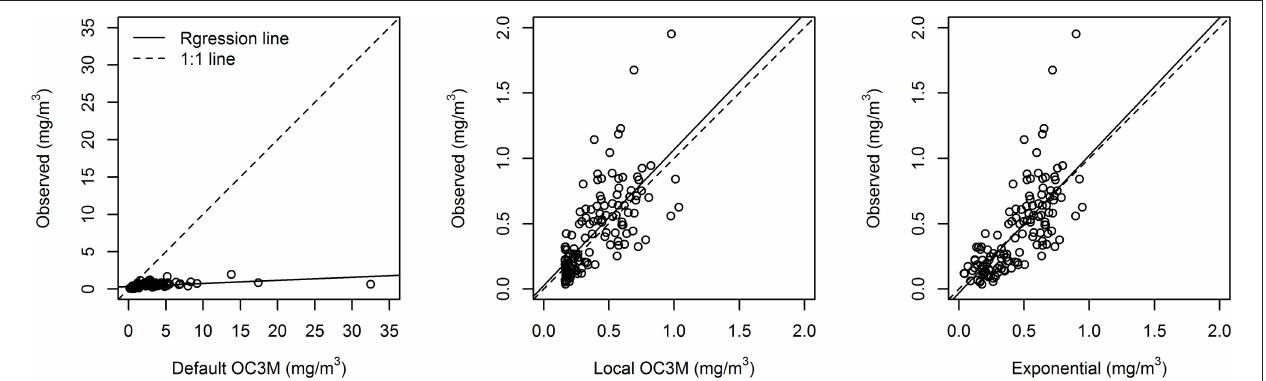
FIGURE 5 | Default (global Case 1) and local model predictions vs. 6-h averaged in situ TASCAM monitoring buoy chlorophyll- a test dataset for the three different model approaches in Tasman Bay. Note that a different scale is used for the global Default OC3M model results.